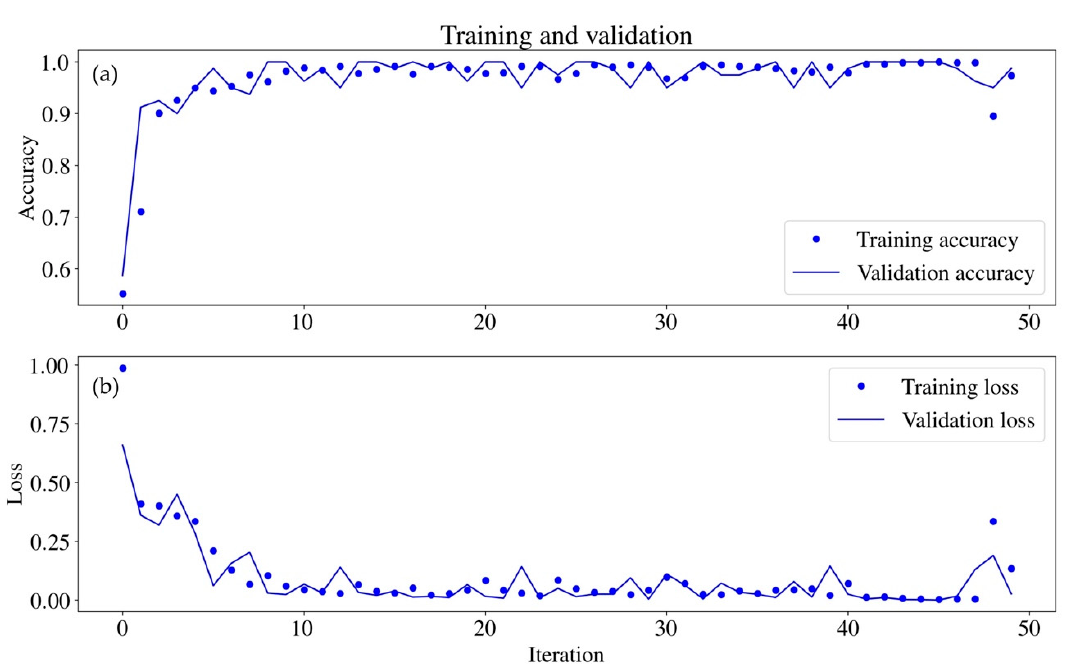
Figure 7. Accuracy ( a ) and loss ( b ) of the training and validation (=testing) data for classification of R. pseudoacacia and Non- R. pseudoacacia , depending on the iterations. Dataset = 1000 images; 80% for training and 20% for testing.